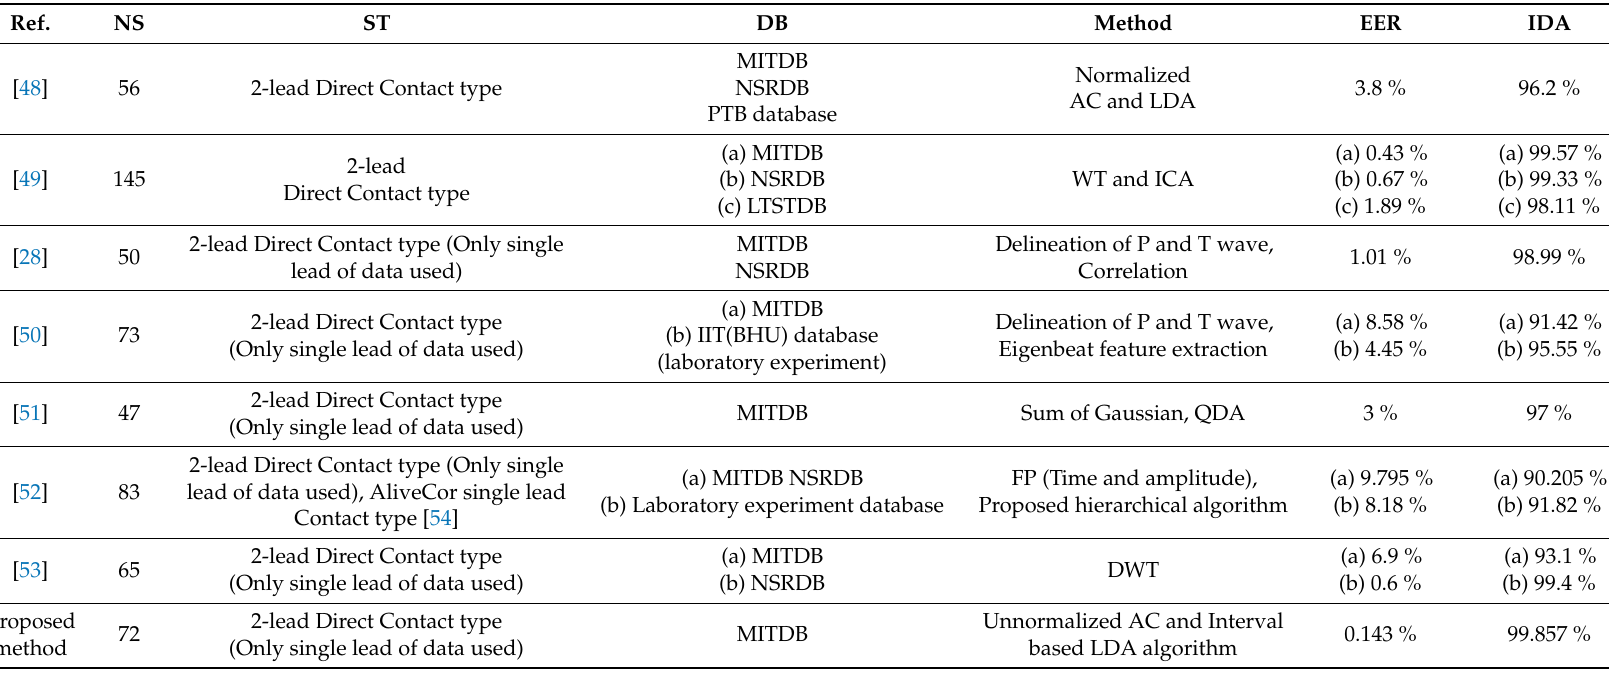
Table 1. Comparison of the proposed algorithm with related research using the same public